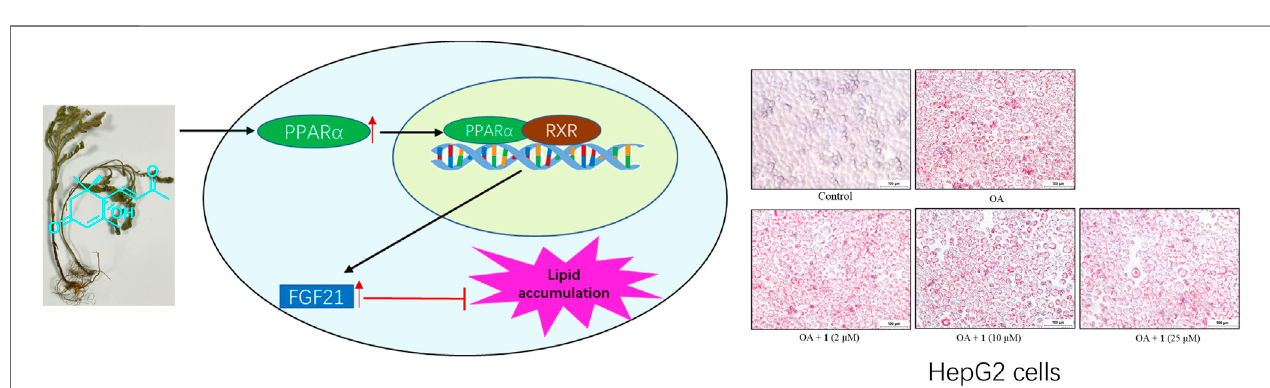
FIGURE 6 | (+)-Dehydrovomifoliol activated the PPAR α -FGF21 pathway to alleviate lipid accumulation.